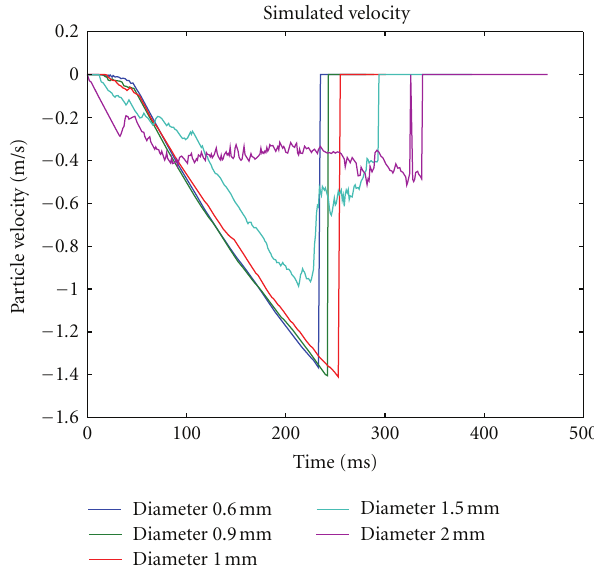
Figure 8: Simulated particle velocity measured at outflow section as a function of particle